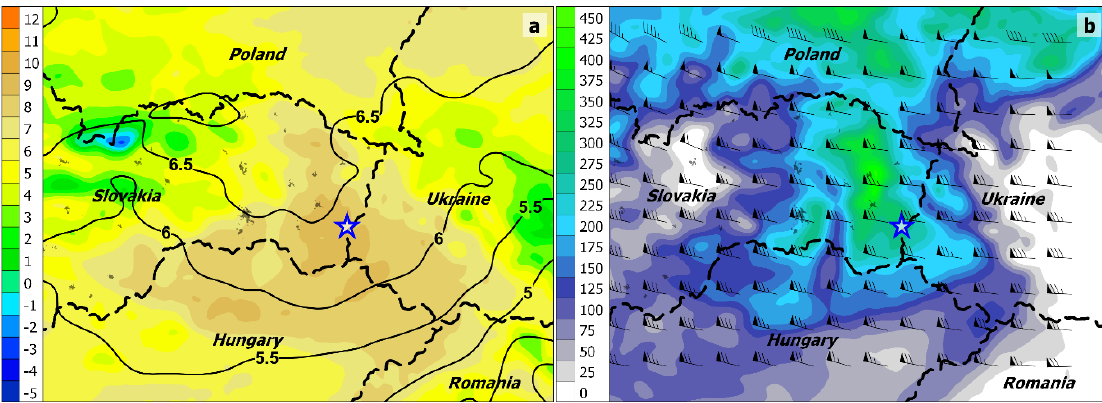
Figure 3. ( a ) NWP OPM forecast on 3 October 2018 06:00 UTC of 12:00 UTC. (a) Average lapse rate in 900–600 hPa layer (black isolines) (°C . km –1 ) and dew-point temperature at 2 m (color scale) (°C); ( b ) surface-based convective available potential energy (CAPE; color scale) (J . kg –1 ) and deep-layer shear (DLS; wind barbs: full barb, 5 m . s –1 ; half barb, 2.5 m . s –1 ; flag, 25 m . s –1 ). Country names shown in italics; tornado location highlighted by blue star.